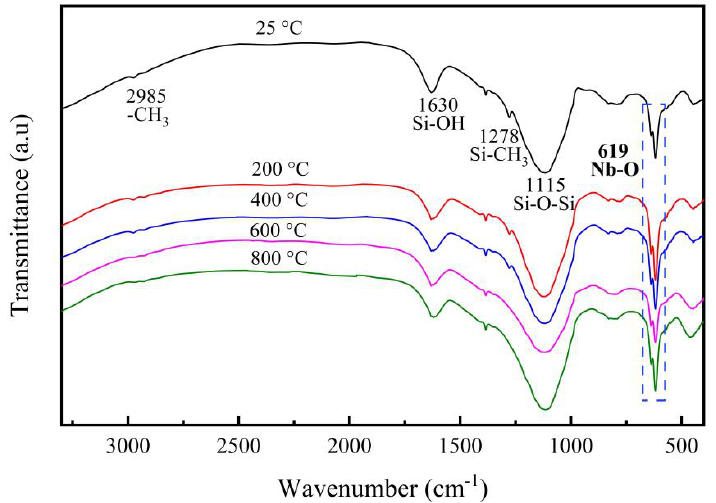
Figure 4. FTIR spectra of Nb/SiO 2 materials with n Nb = 1 calcined at various temperatures.